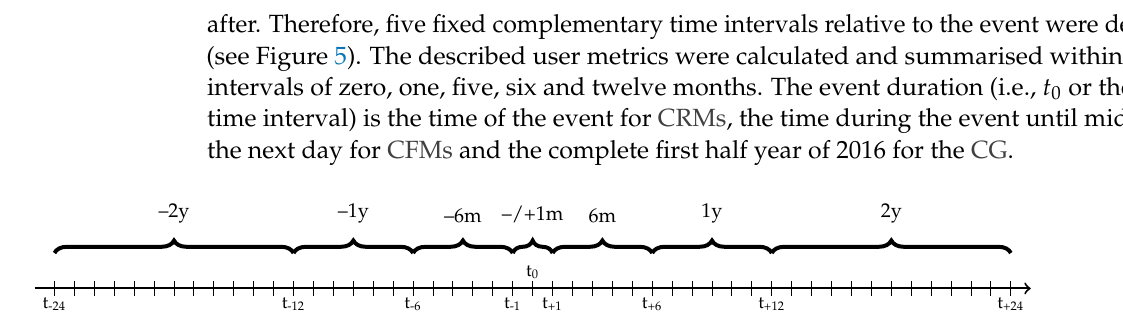
Figure 5. Summary time intervals for analyses. t 0 defines the event. Variables were calculated for the displayed time intervals during the event, one, six, twelve and 24 months before and